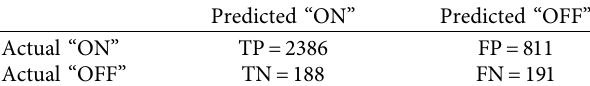
Table 2: The “confusion matrix”